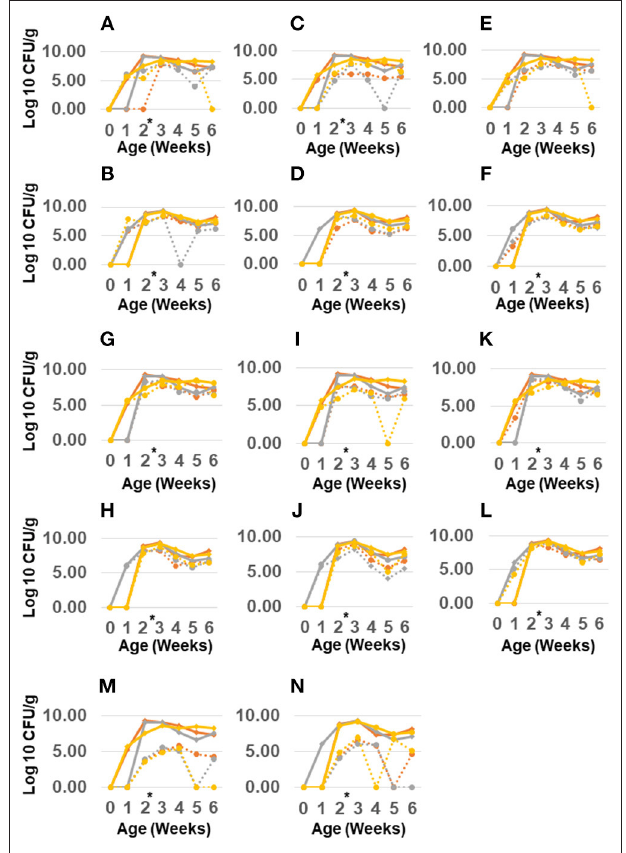
FIGURE 2 | Abundance of antimicrobial resistant Gram-negatives in chickens administered poultry litter resistome and antibiotics. Salmonella Typhimurium 934R was orally administered to 1 day old chicks with (B,D,F,H,J,L,N) or without (A,C,E,G,I,K,M) poultry litter resistome. At 2 weeks of age (black arrow), chlortetracycline (gray line), or streptomycin (yellow line) was administered; control birds received no antibiotic treatment (red line). Abundance of Gram-negatives resistant to streptomycin (A,B) , gentamicin (C,D) , kanamycin (E,F) , tetracycline (G,H) , chloramphenicol (I,J) , ampicillin (K,L) , or nalidixic acid/rifampicin (M,N) was determined from plating samples on MacConkey agar with antibiotic (dashed lines). MacConkey agar without antibiotics was used to enumerate total Gram-negatives (solid line). *Antibiotic treatment at 2 weeks of age.